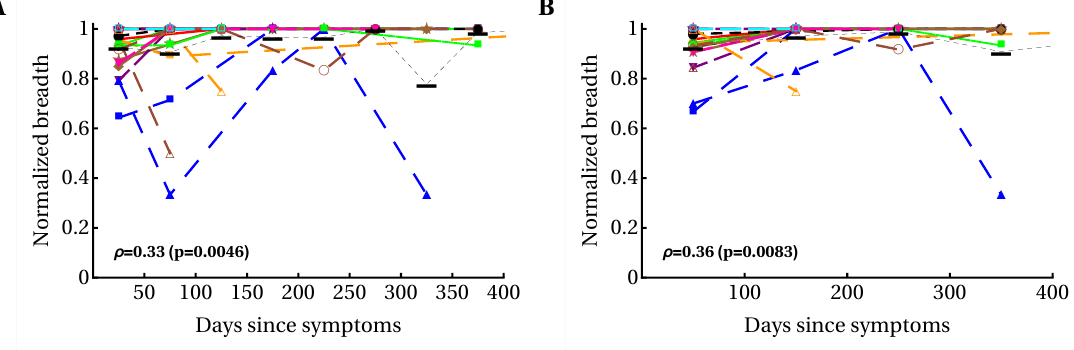
Figure 3. Modest yet statistically significant increase in the average normalized T-cell response breadth over the course of the first year of HIV infection. We divided the observations into different time bins (( A ) 50-day intervals; ( B ) 100-day intervals) and calculated the relative breadth for the corresponding interval. The relative breadth was calculated as the number of HIV-specific CD8 + T-cell responses detected in a given time period divided by the number of all responses measured for that patient in all time periods; data were averaged to simplify presentation. Averaging did not influence the statistical significance of conclusions. Colors and symbols represent the data from different patients as shown in Figure S5 in Supplementary Material. Black horizontal bars denote the mean relative breadth for that time interval for all patients. There was a statistically significant increase in relative breadth (Spearman’s rank correlation coefficient ρ and p values indicated on panels). There was no change in the average total immune response in all patients (Figure S6). Detailed analysis of the relative number of CD8 + T-cell responses in individual patients revealed variable patterns: constant breadth, increasing breadth, decreasing breadth, and breadth changing non-monotonically over time (Figure S7). Also, no overall change in the average breadth (un-normalized) was observed (Figure S5). We observed a similarly modest but significant increase in SE and EI of HIV-specific CD8 + T-cell response with time (Figure